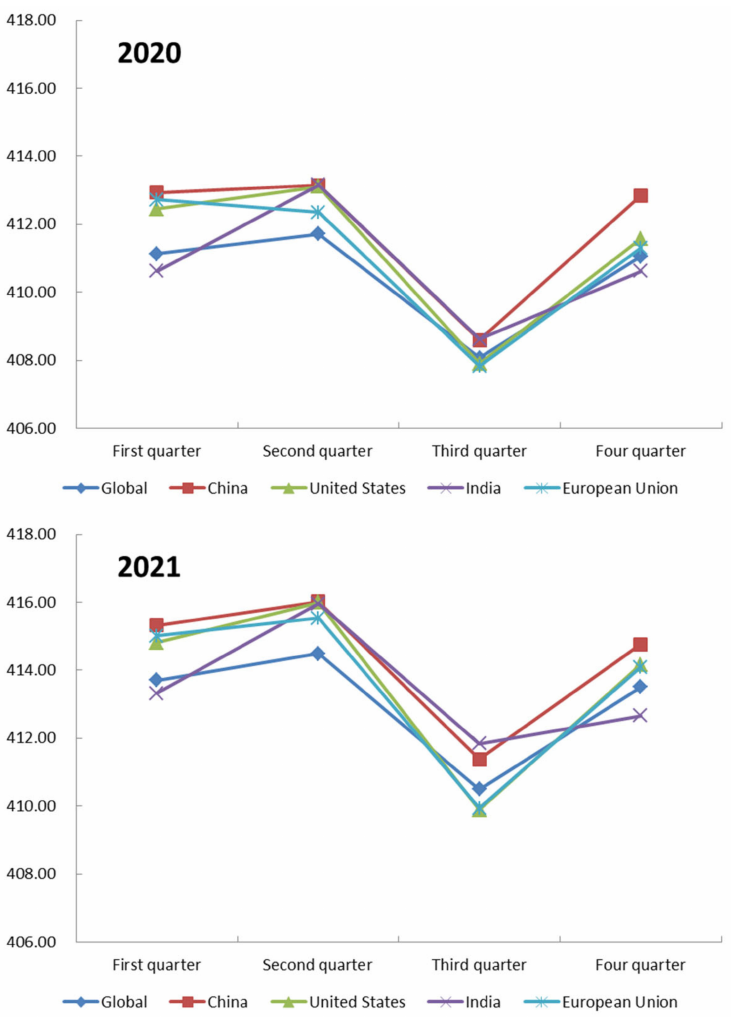
Figure 2. CO 2 concentration trends of global land and major countries/regions in 2020 and 2021.